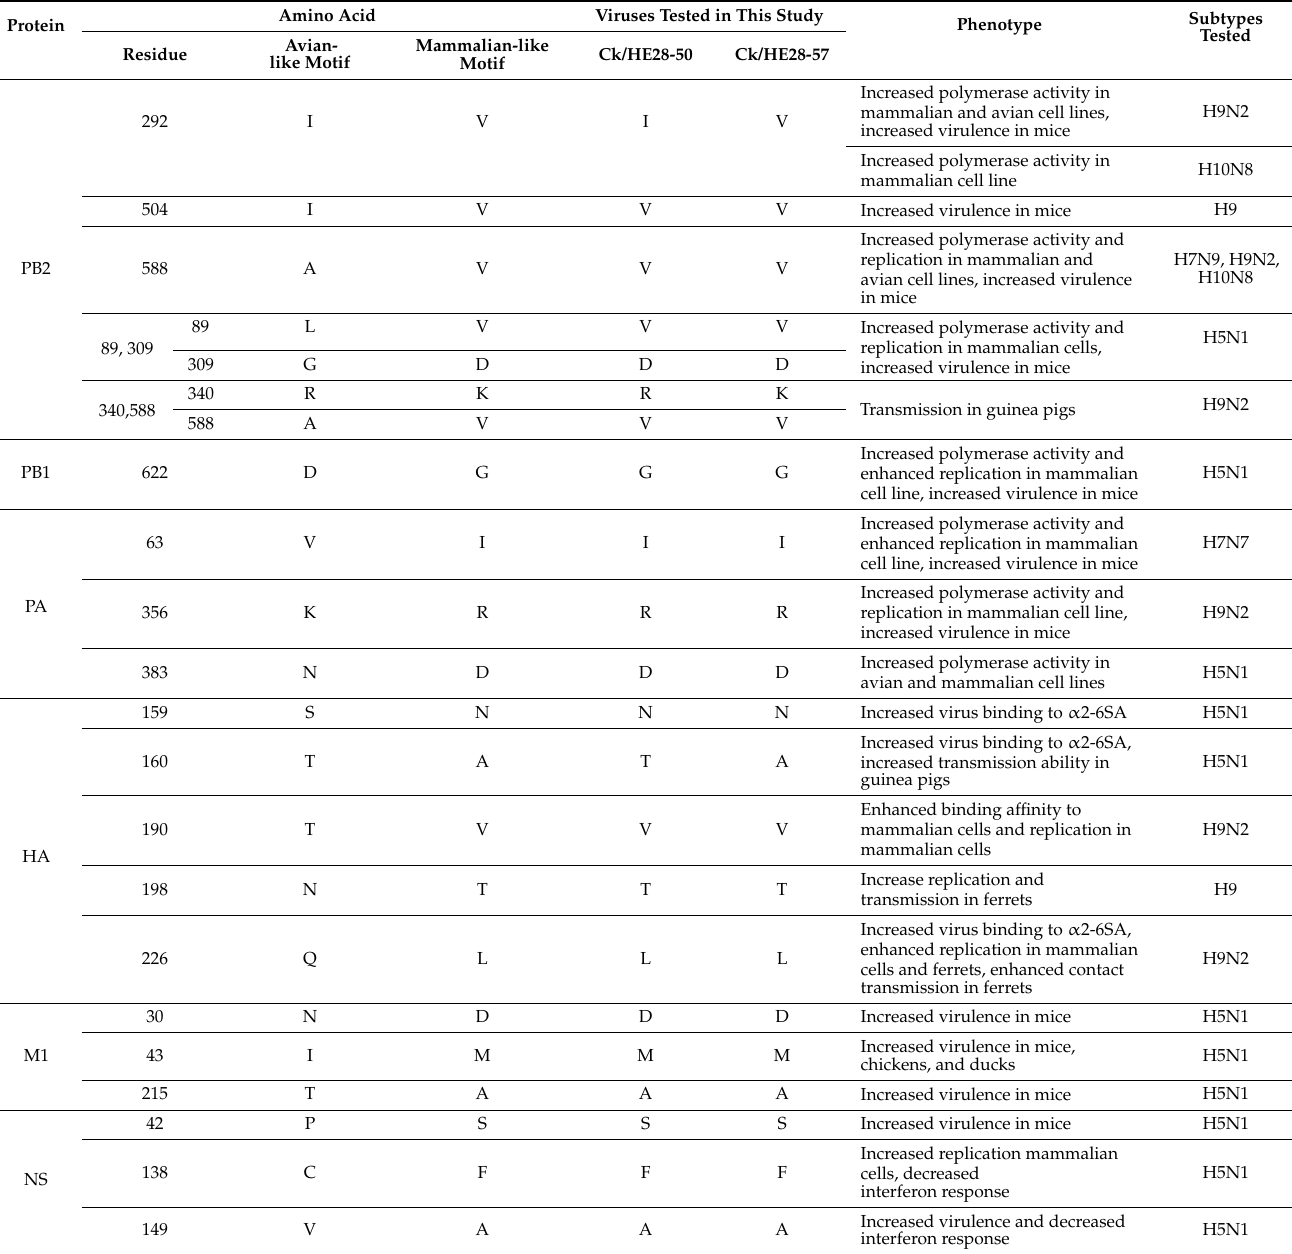
Table 1. Molecular markers associated with the adaptation of avian influenza viruses to mammalian hosts found in the viral proteins of the H9N2 viruses Ck/HE28-50 and Ck/HE28-57 a . Amino Acid Viruses Tested in This Study Phenotype Protein Residue Avian- like Motif Mammalian-like